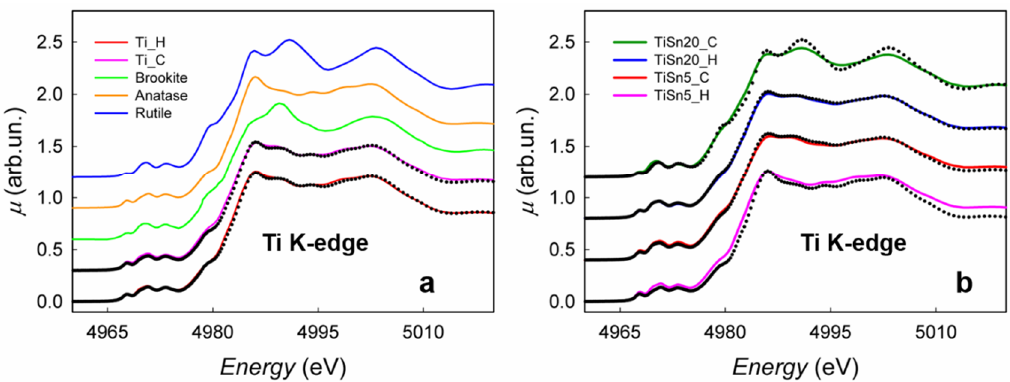
Figure 1. ( a ) X-ray absorption (XAS) spectra at the Ti K-edge of rutile, anatase, brookite, Ti_C, and Ti_H. The linear combination fits for Ti_C and Ti_H are shown by the correspondent black dotted lines. ( b ) XAS spectra at the Ti K-edge of TiSn20_C, TiSn20_H, TiSn5_C, and TiSn5_H. The black dotted lines in correspondence with TiSn20_C and TiSn5_H are the reference spectra of rutile and anatase, shown for the sake of comparison, while the black dotted lines in correspondence with TiSn5_C and TiSn20_H are the result of the linear combination fit, as listed in Table 1.